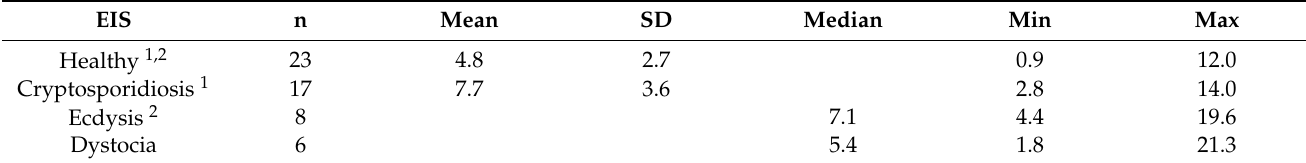
Table 1. Comparison of corrected erythrocyte sedimentation rate (ESR corrected ) measurements between healthy eastern indigo snakes (EIS) and EIS with inflammatory conditions cryptosporidiosis, ecdysis and dystocia. ESR corrected values are reported in